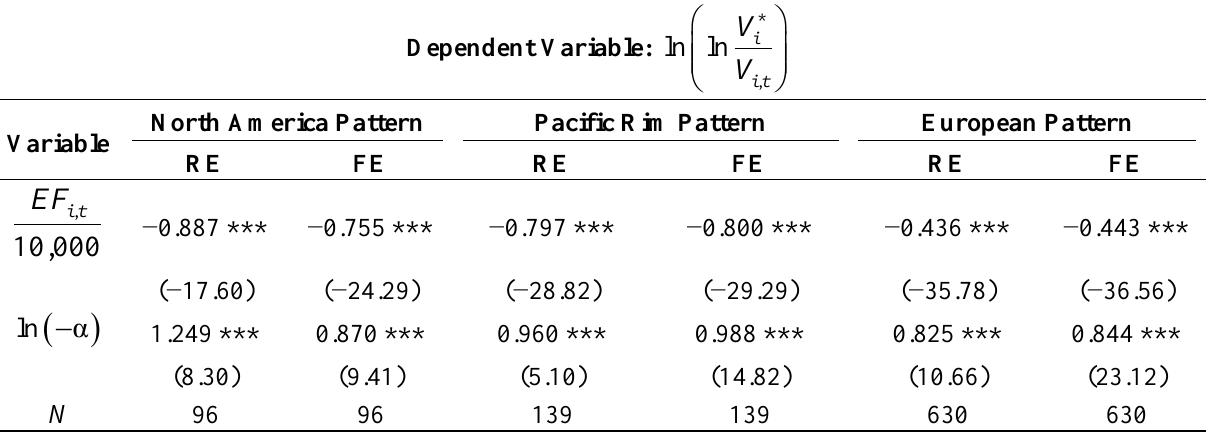
Table 2. Panel Regression in the Gompertz function.